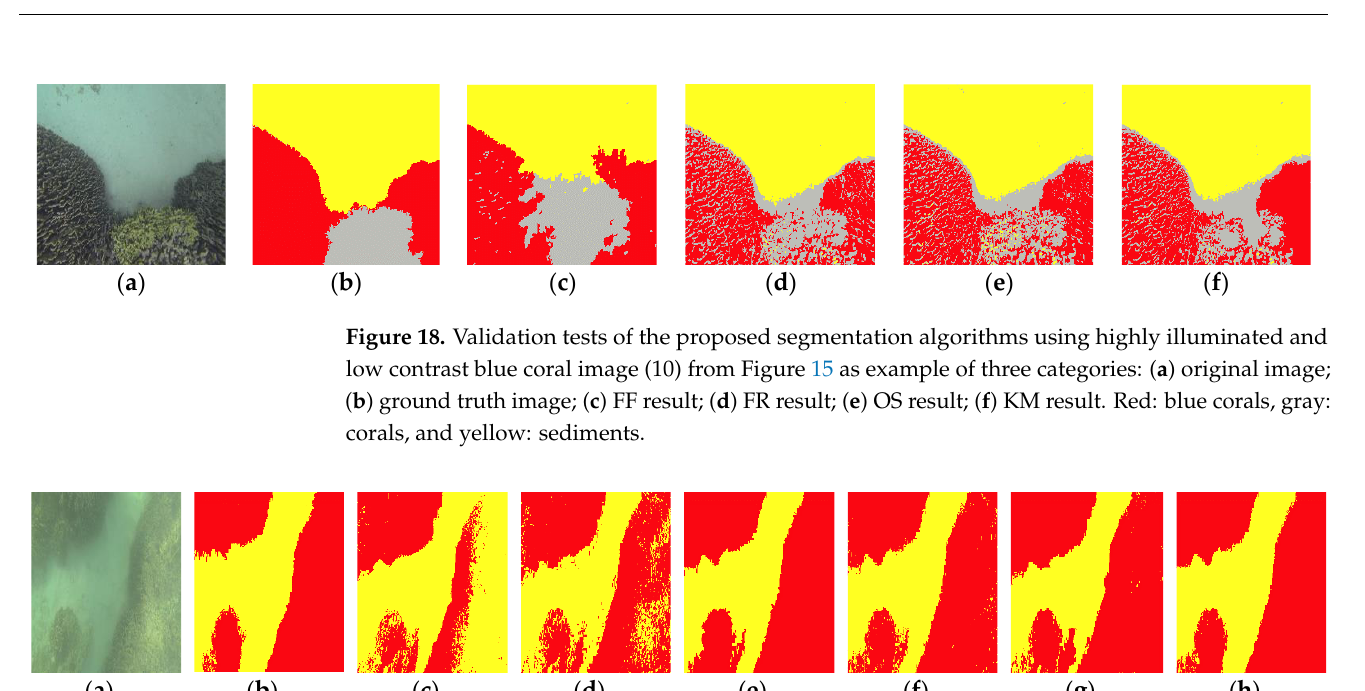
Figure 19. Validation tests of the proposed segmentation algorithms using low illuminated and high contrast blue coral image (1) from Figure 16 as example of two categories: ( a ) original image; ( b ) ground truth image; ( c ) KM result; ( d ) KMAc result; ( e ) FFCr result; ( f ) FRCr result; ( g ) OSCr result; ( h ) KMCr result. Red: blue corals and yellow: sediments.